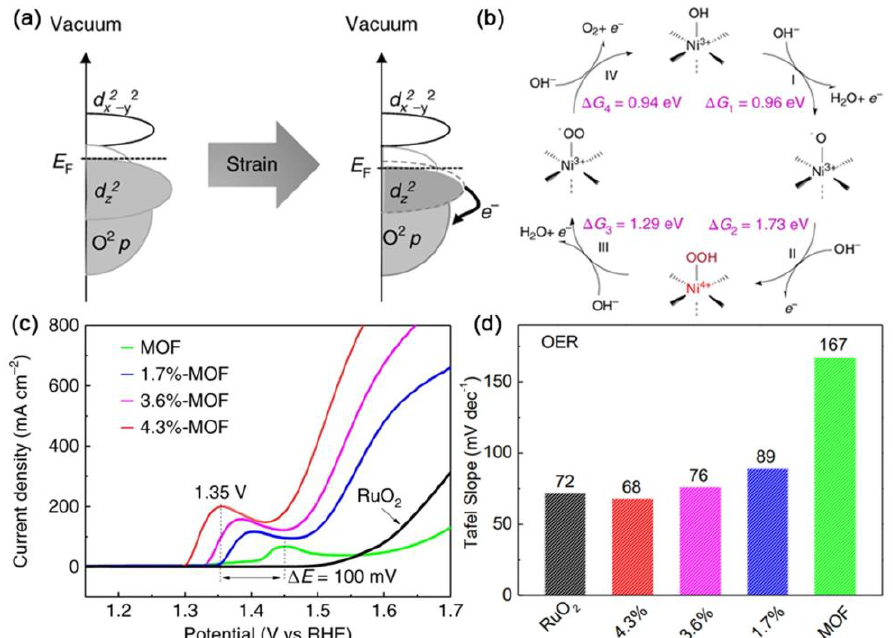
Figure 5. ( a ) Schematic illustration of the electron exchange for the lattice − strained NiFe MOF. ( b ) Proposed OER catalytic mechanisms for the lattice-strained NiFe MOF. ( c ) LSV curves and ( d ) Tafel slope values of OER for the pristine, 1.7% − , 3.6% − and 4.3% − NiFe MOFs. Reproduced with permission from ref. [101]. Copyright 2019, Springer Nature.